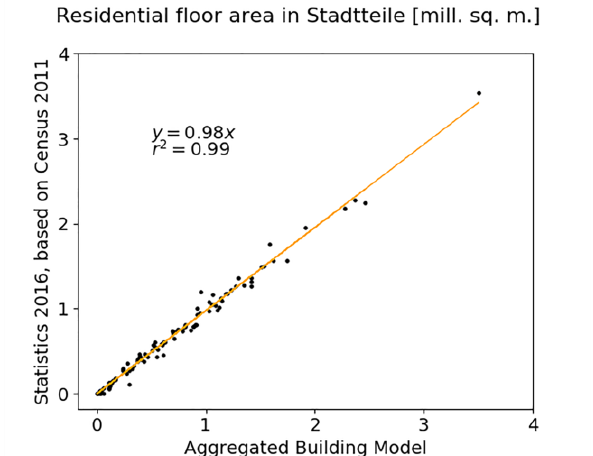
Fig. 3. Correlation between estimated residential floor area and official statistics at the “ Stadtteil ” level (an administrative division of Hamburg). Validating the non-residential floor area at these scales is not possible, since there are no official statistics on